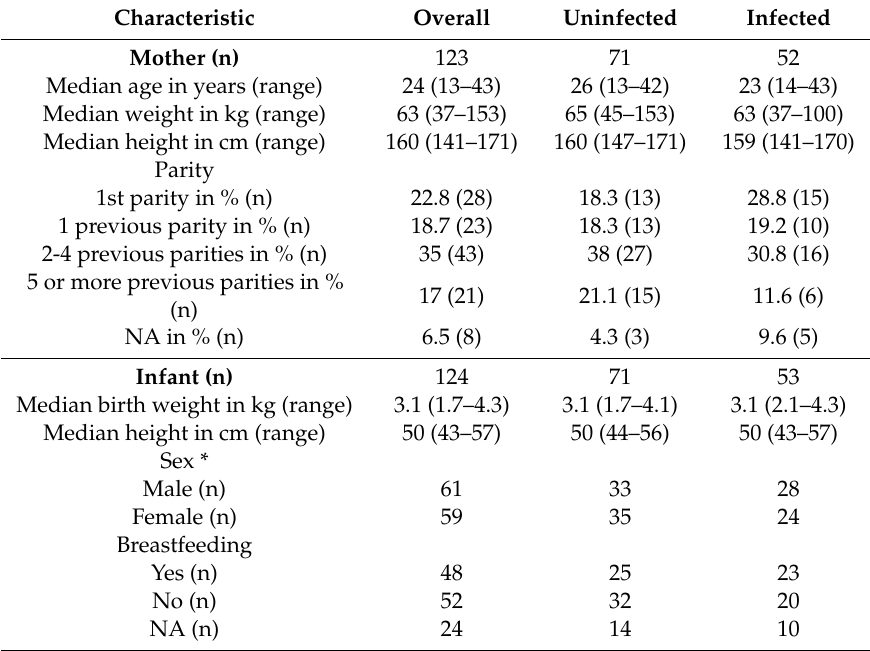
Table 1. Baseline characteristics of mothers and their infants overall and considering the helminth infection status of the